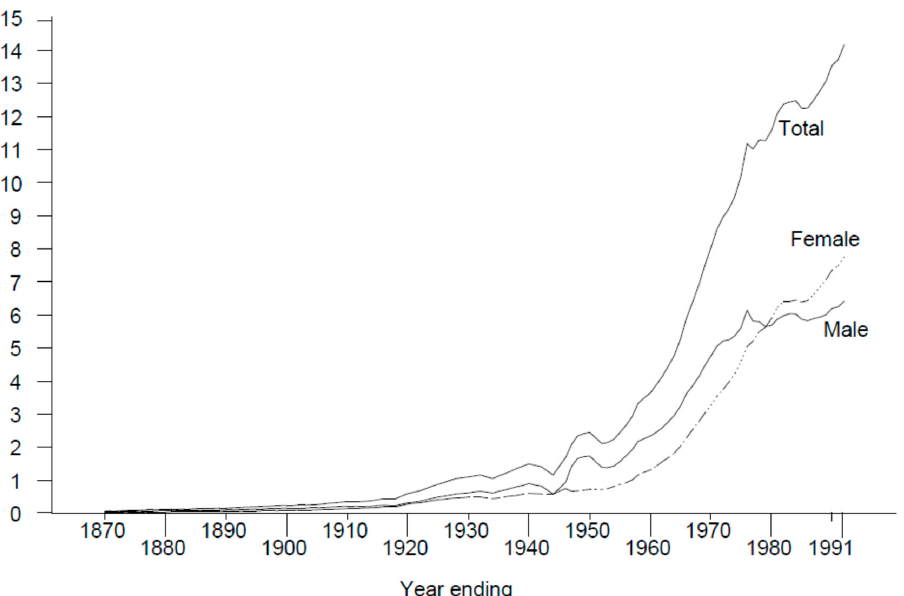
Figure 1. Enrollment in Institutions of Higher Education, by Sex—1869–70 to 1990–91, Millions Source: [60] (p. 65).